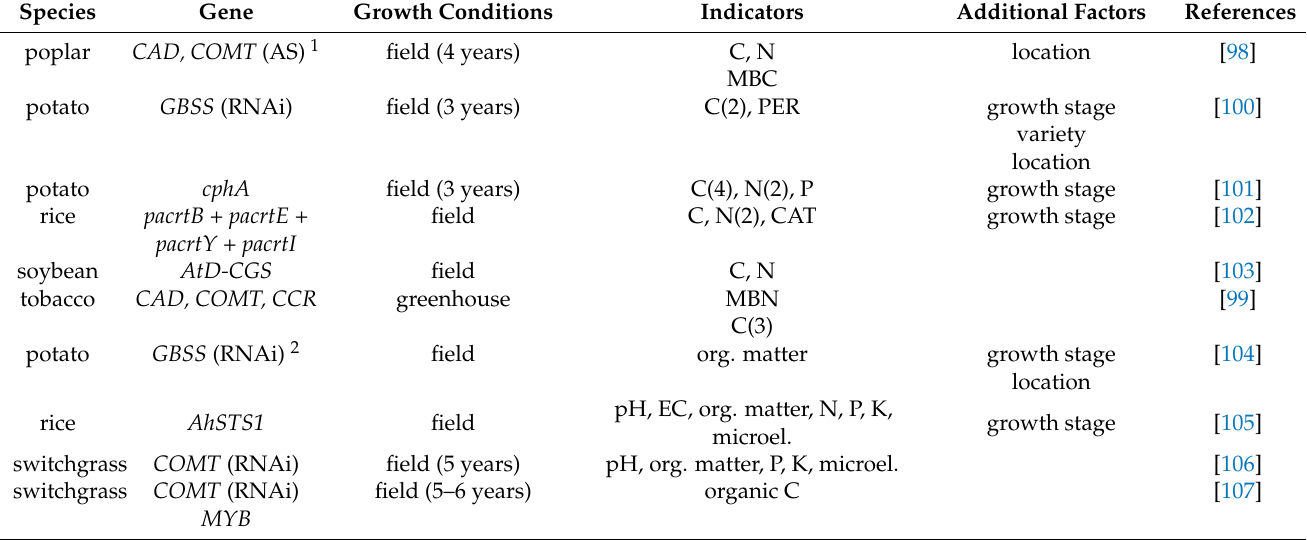
Table 5. Risk assessment of metabolic engineered transgenic plants on soil